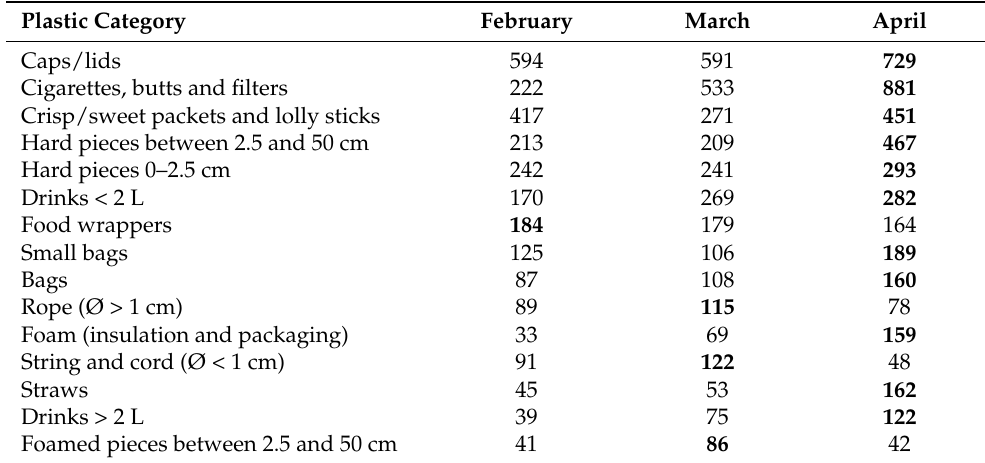
Table 4. Number of items of the most represented plastic litter categories per month. The highest values are highlighted in